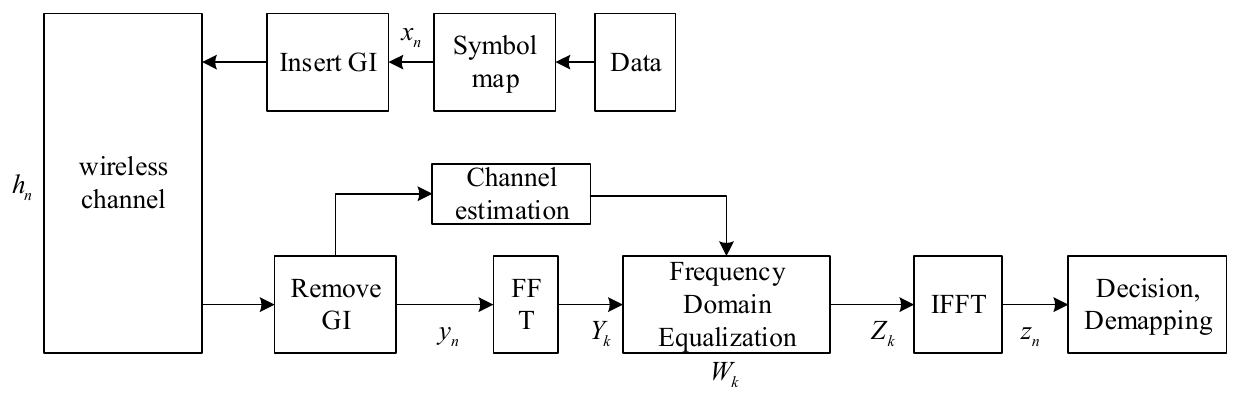
Figure 1. SC-FDE system principle structure diagram.